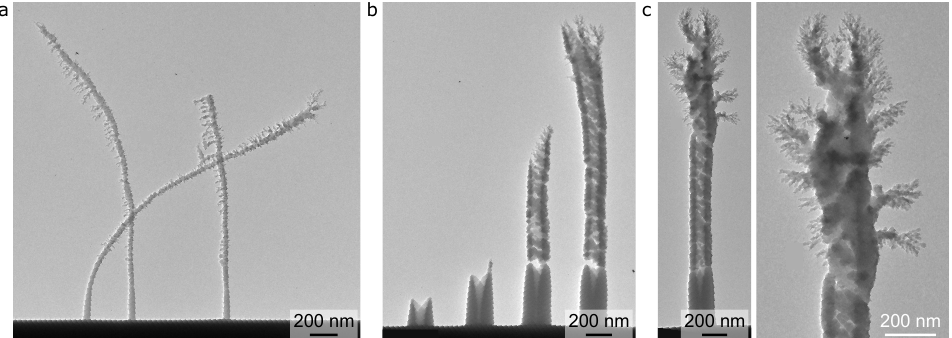
Figure 4. Insulator deposition of nanopillars and nanocylinders by helium FIBID using a higher precursor flow rate (chamber pressure 1 × 10 − 5 Torr, beam current 1pA, silicon substrate): ( a ) Bright- field TEM of nanopillars (deposition times from left to right: 2, 2 (repeat), and 4 s—the latter snapped, hence the height is reduced). ( b ) Bright-field TEM of nanocylinders (deposition times from left to right: 7, 14, 21, and 28s). ( c ) Bright-field TEM and higher-magnification view of an additional nanocylinder (deposition time